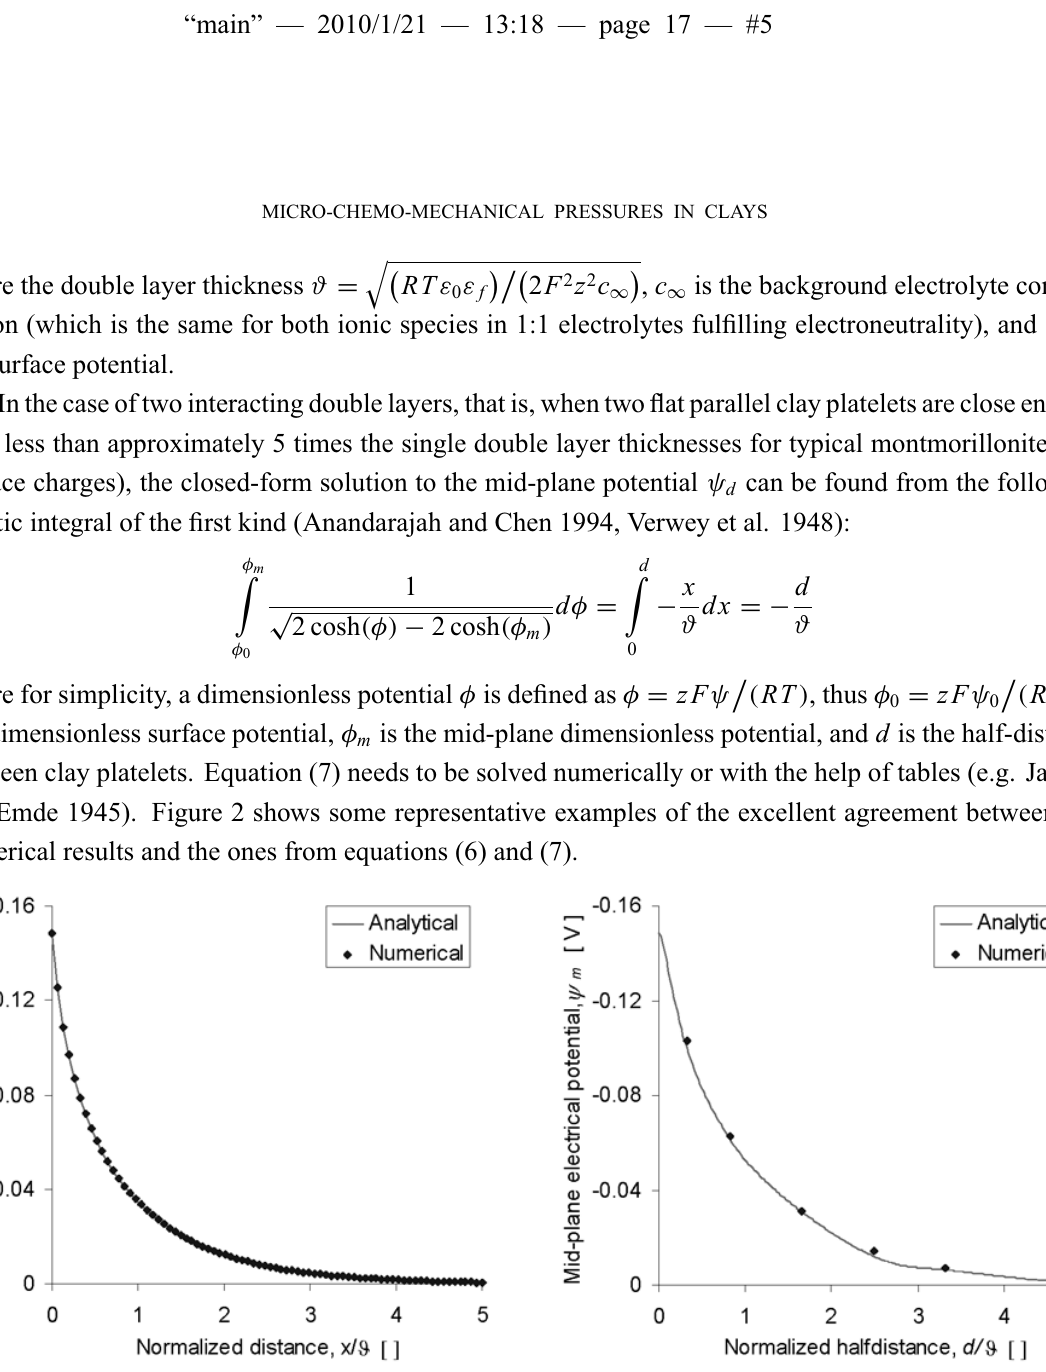
Fig. 2 – Example comparison between analytical and numerical solutions: for single ( left ) and for interacting ( right ) double layers of two infinitely long parallel plates. Lengths are normalized by the double layer thickness ϑ , x represents distance from the clay surface, d is the half-distance between two parallel clay platelets and ψ is the electrical potential (c σ . 108 C 2 are = − 0 ∙ m −